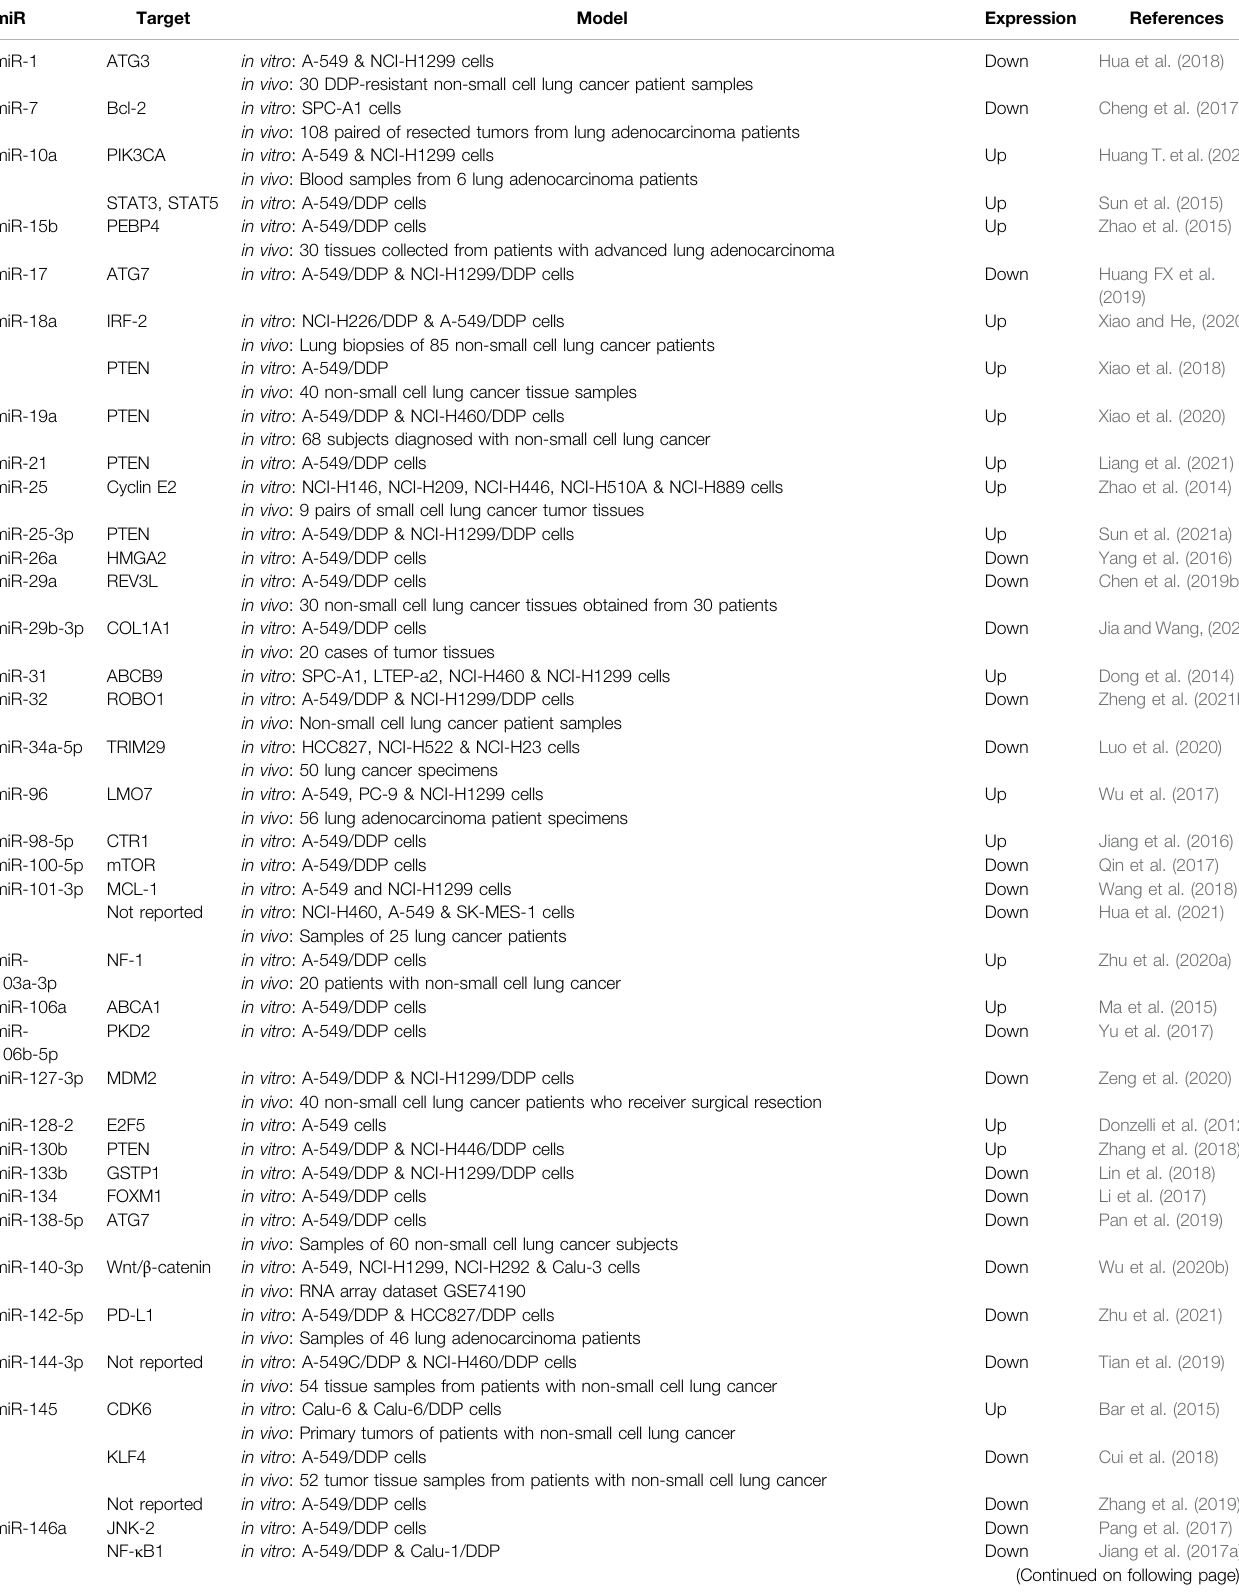
TABLE 1 | MicroRNAs involved in DDP-chemoresistance in lung